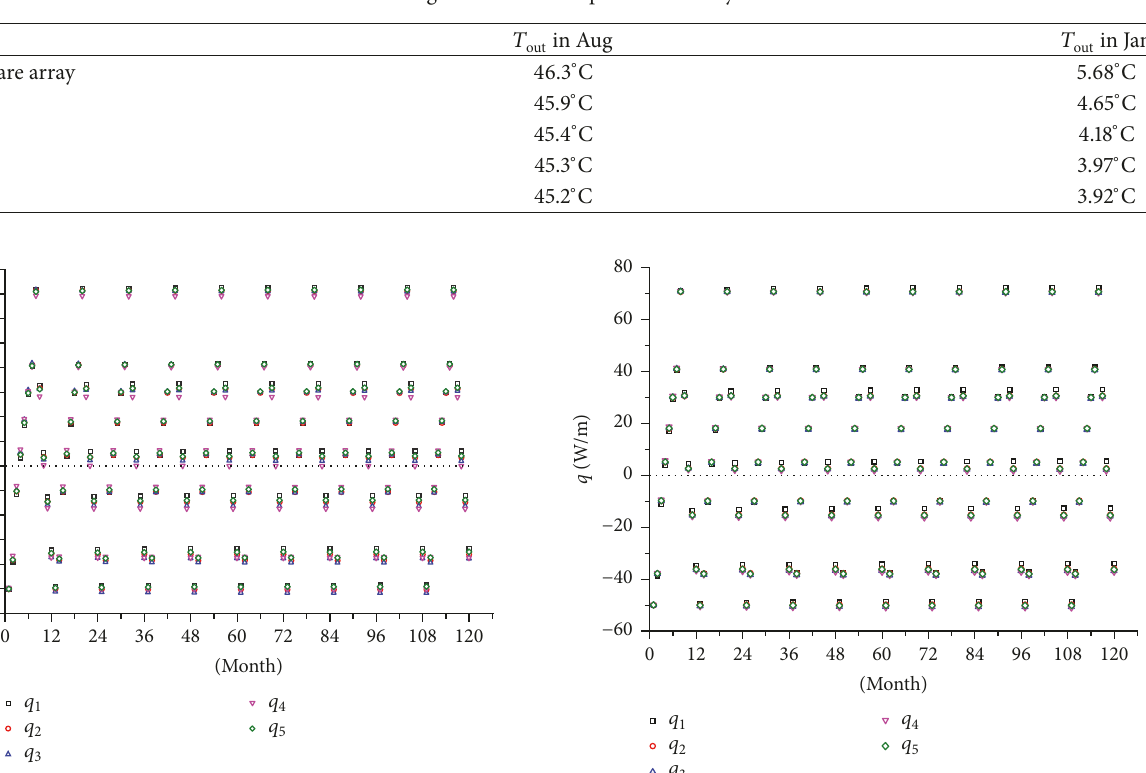
Table 5: Average outlet fluid temperatures in 10 years.